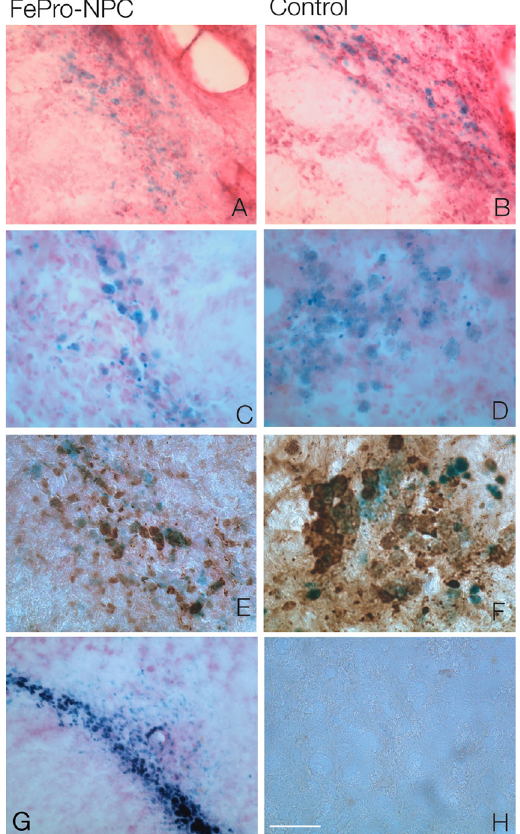
Figure 6. Histological analysis at 28 days at the ipsilateral striatum. A , B , Prussian blue stain for iron and hematoxylin-eosin staining at the ipsilateral striatum. Iron detected in the ischaemic lesion. C , D , Prussian blue stain with nuclear fast red counterstain in the ipsilateral striatum. E , F , OX-42 immunohistochemistry stain for macrophage/microglia, and Prussian blue stain for iron. Prussian blue-positive and – negative macrophage/microglia, detected by OX-42, are present at the ischaemic lesion. G , Prussian blue stain at the injection site in FePro-NPC ipsilateral hemisphere. H , OX-42 immunohistochemistry for macrophage/microglia and Prussian blue stain in the contralateral hemisphere. No macrophage/microglia or iron were observed in the striatum or cortex of the contralateral hemisphere. Scale bars, 30 µm.